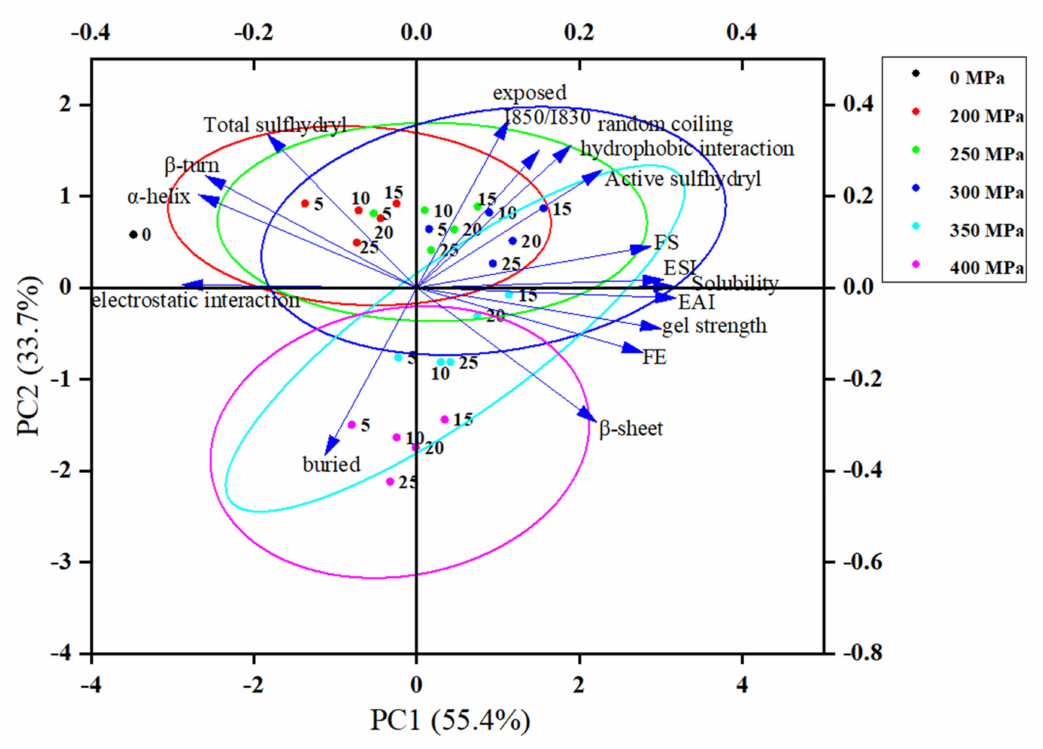
Figure 4. Factor loading diagram of two principal components of the functional properties and structural characteristics of cowhide gelatin induced by high hydrostatic